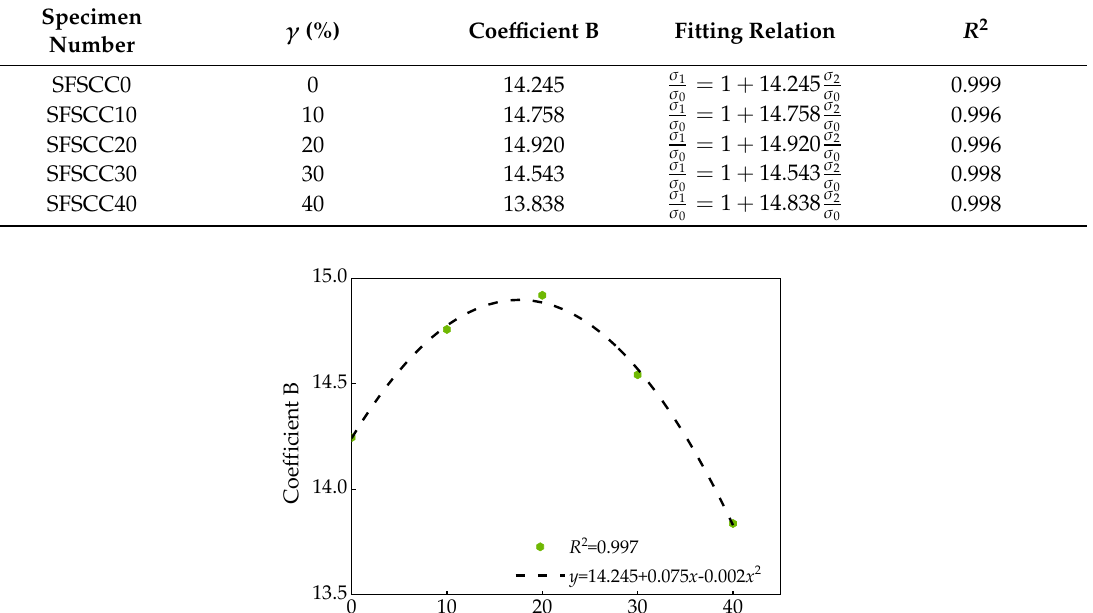
Table 9. Fitting relationship of SCC.